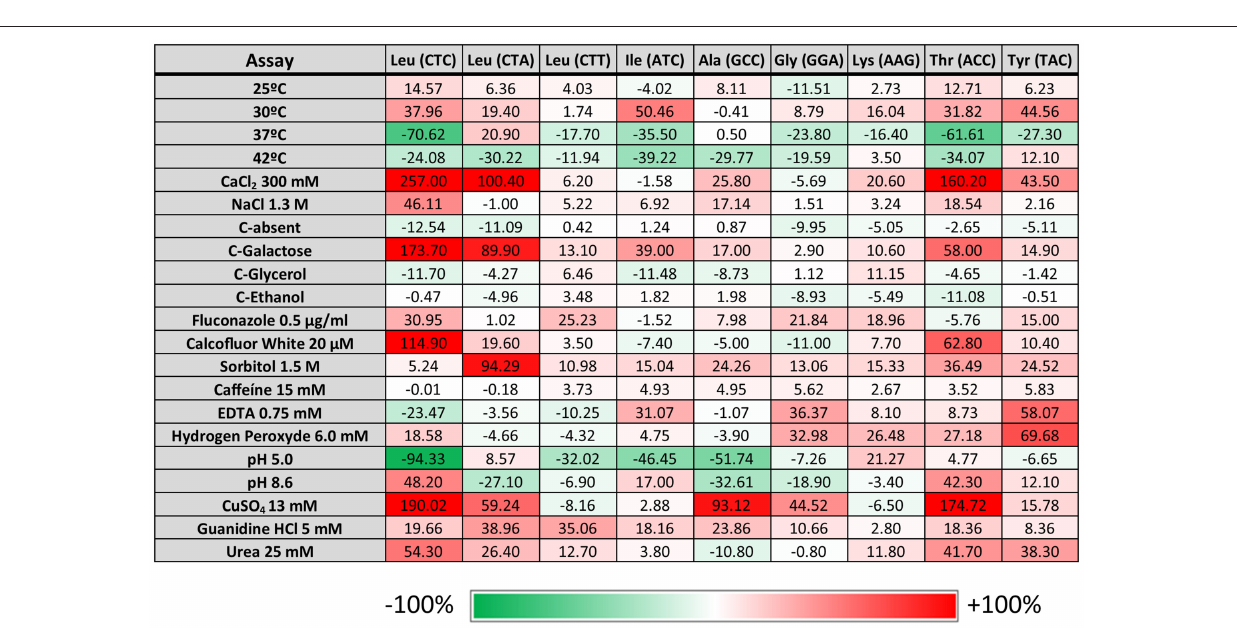
FIGURE 2 | Phenotypic assays. Data represent the average size of the colonies obtained for all the transformed cells after 5 days of growth under the indicated conditions normalized with growth at 30 ◦ C and compared with the normalized control pUA552 (considered 0%) for that condition (relative growth score). The assay was performed with two independent growth cultures and three independent clones. Brick color intensity represents the strength of the phenotype. White squares represent a phenotype that is indistinguishable from the control strain pUA552. Green and red squares represent either a growth reduction or enhancement,